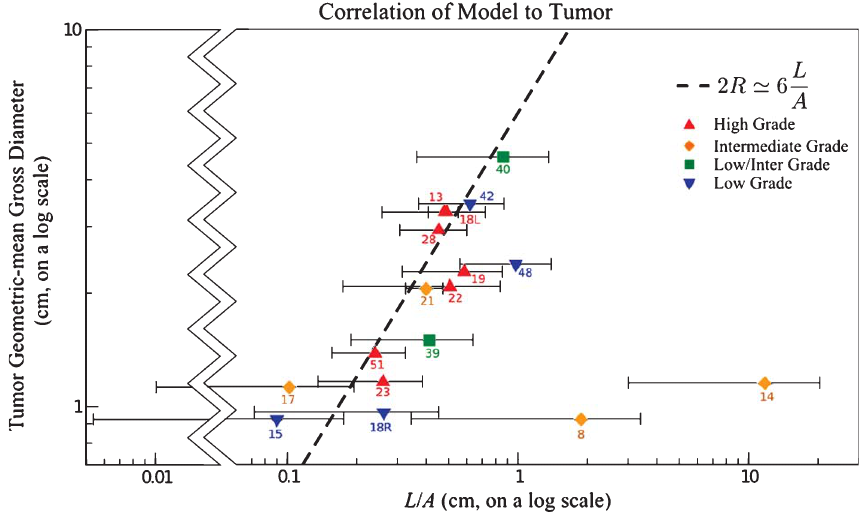
Fig. 2. Tumor size correlates with the death-to-proliferation ratio parameter. Tumor geometric-mean diameters 2 R (dashed) vs. A/L predicted by Eq. (5) compared to the corresponding pathology measurements from the 17 excised tumors (symbols, with de-identified case numbers). Standard errors of the mean (SEMs) are reported [46, 47] (see Methods for details) (see also Table 2). SEMs for L/A were calculated as the summation of the first order in Taylor expansion from the variability of the AI and PI stains and the viable-rim thickness measurements in each tumor. For an explanation of cases 8, 14 and 48 see text of Results section. Previously [30, Fig. 10.8], we used the 2008 batch of patient tumor volume data alone (cases 8–28) to assess the feasibility and accuracy of a prototype parameter calibration